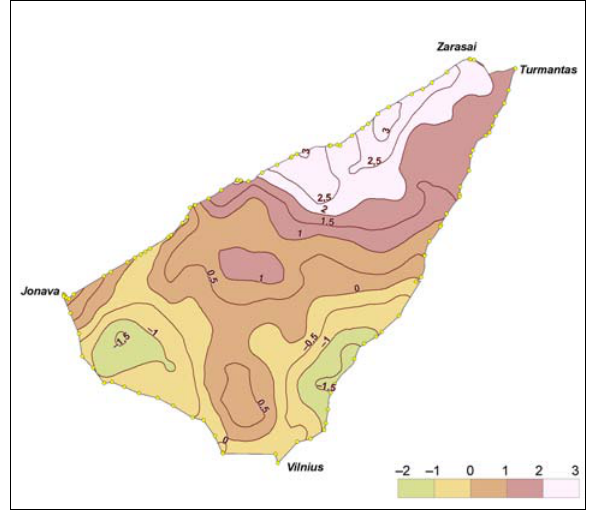
6 pav. Pagal (18) regresin į model į prognozuotas dabartinis tektoninis fonas (judesi ų grei č iai mm per metus) Fig 6. The present tectonic background (movements mm per year) according to the regression model (18)